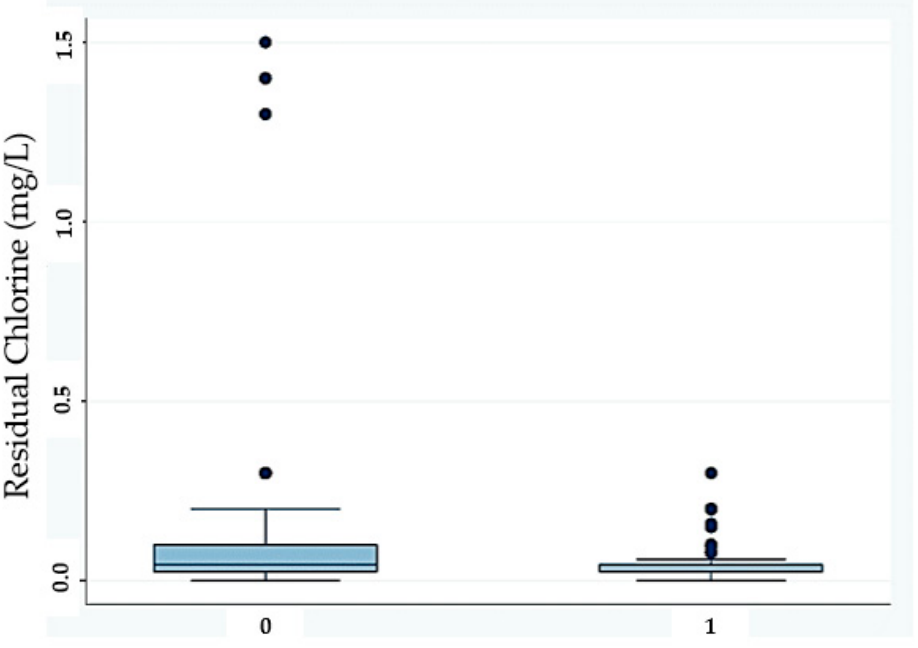
Figure 4. Boxplot showing the influence of chlorine residue (expressed in mg/L) on the presence of Legionella . 0 = No Legionella detected (N = 2156), and 1 = Legionella detected (N = 689).